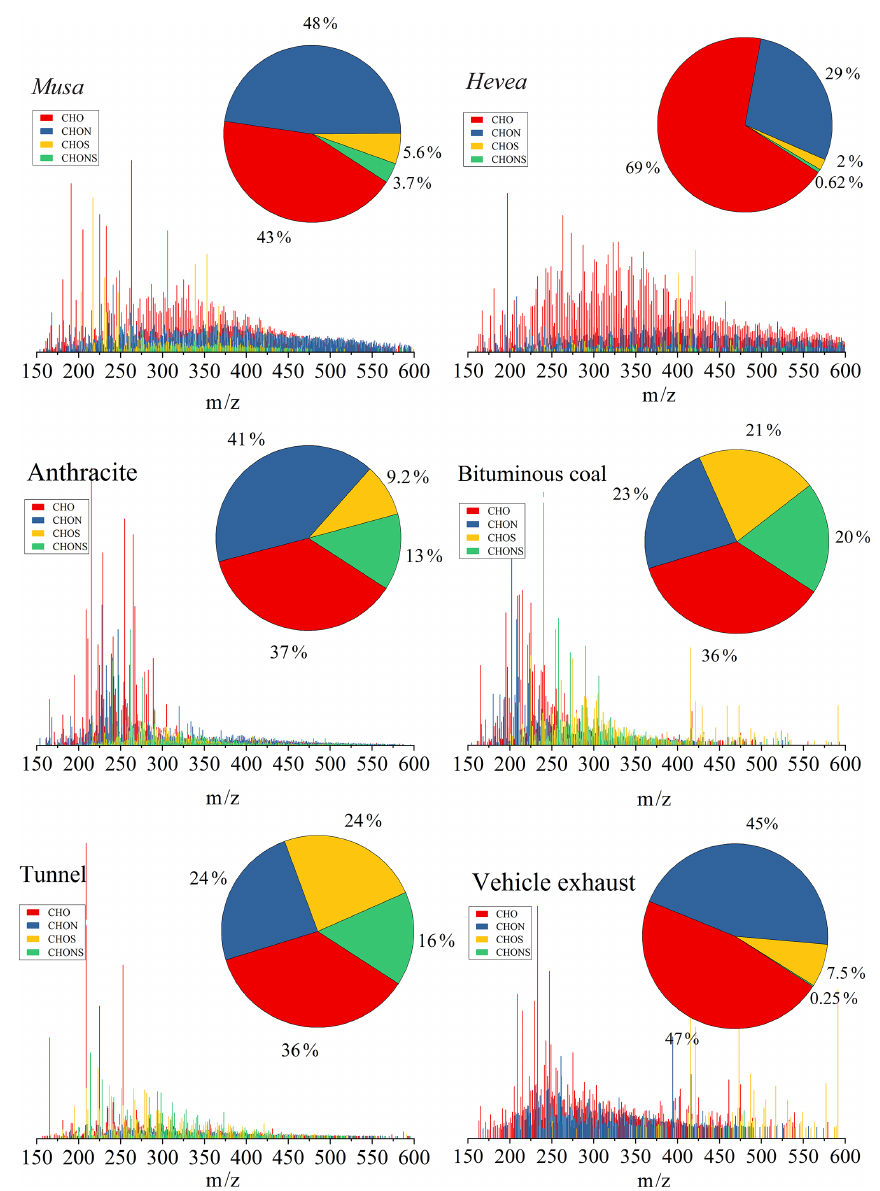
Figure 4. Negative ESI FT-ICR mass spectra of WSOC from the six aerosol samples. Different formula groups were color-coded. The six pie charts showed the relative intensities of different formula